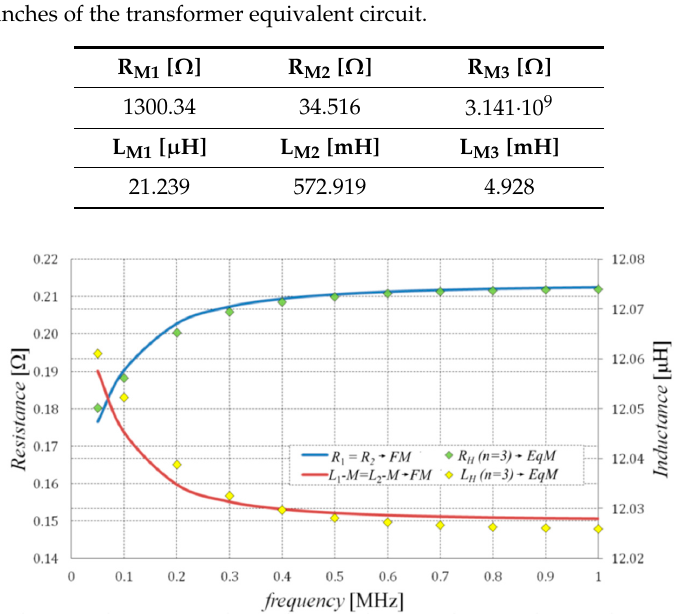
Table 1. The values of resistances and inductances calculated for the Cauer circuit representing the horizontal branches of the transformer equivalent circuit.